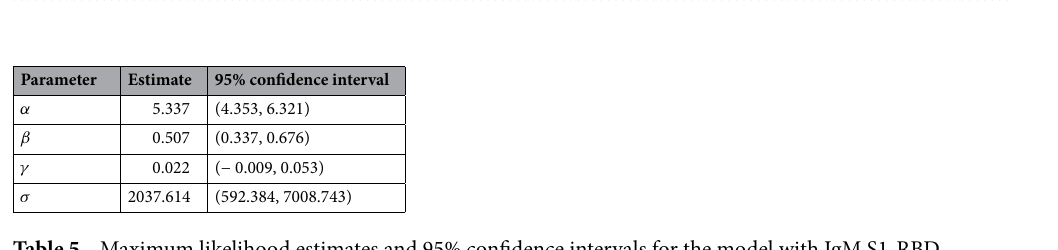
Table 5. Maximum likelihood estimates and 95% confidence intervals for the model with IgM S1-RBD.